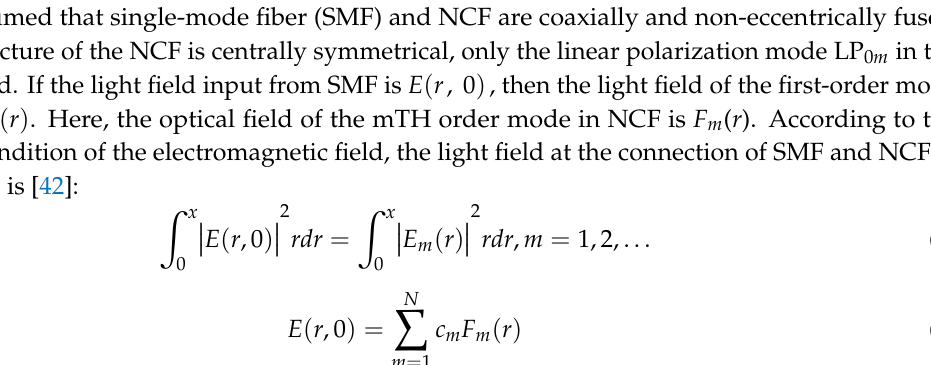
Figure 1. Schematic diagram of sensor and physical picture of no-core fiber.